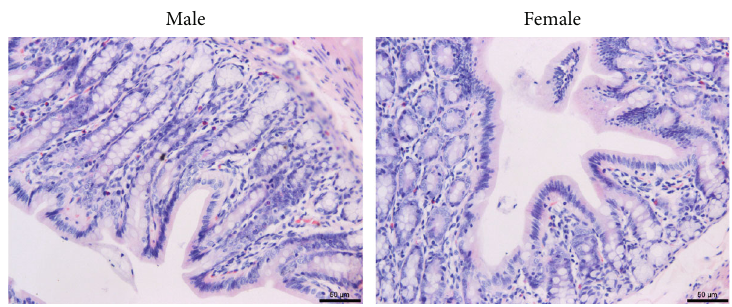
Figure 3: Colon tissue HE staining of rats in the model group. Magni fi cation, ×